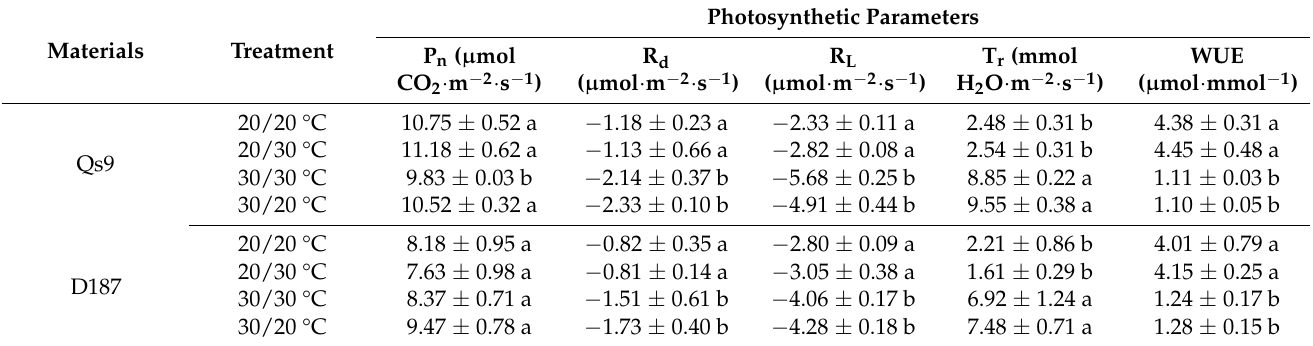
Table 1. The photosynthetic parameters of the Qs9 and D187 plants under the heat-stress treatment of different plant